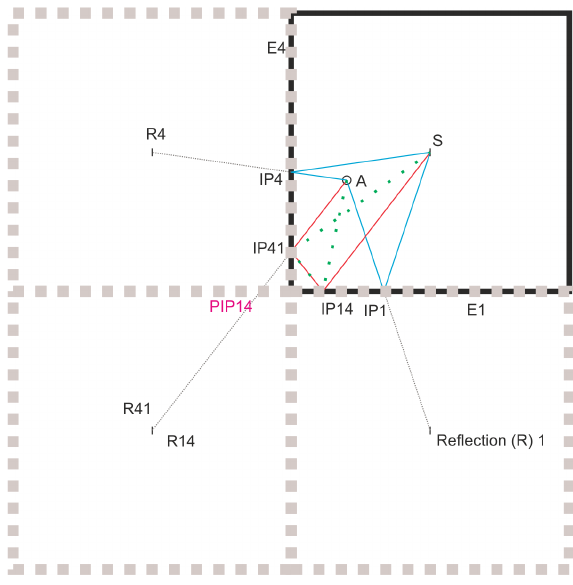
Figure 4. Example of order1 and order2 reflection